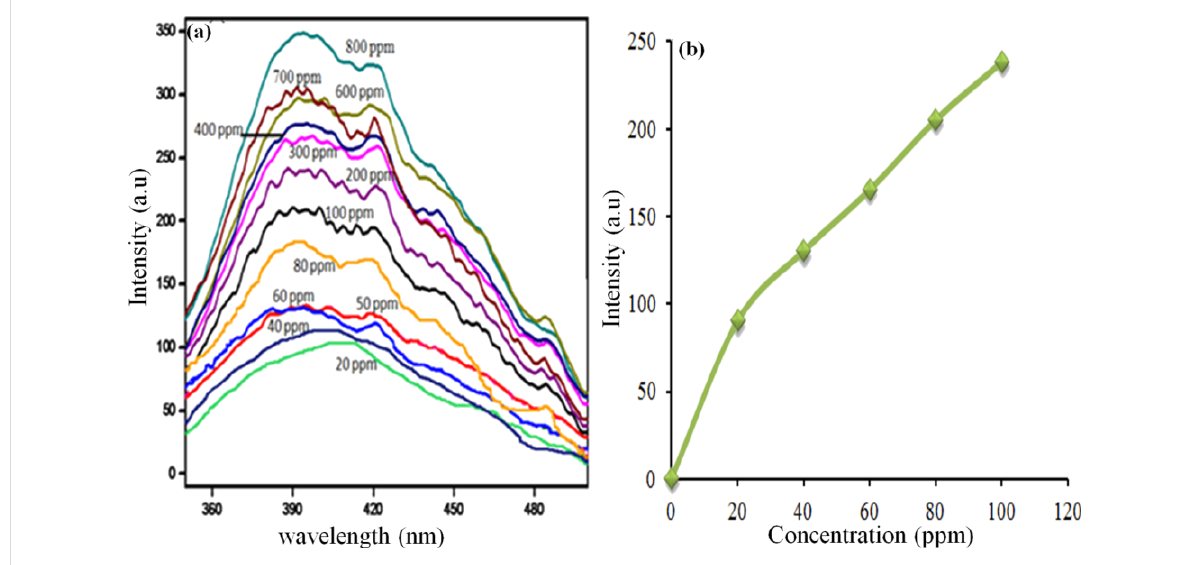
Figure 10: (a) Fluorescence intensity of Au–DNA nanocomposites with increasing concentration (ppm) of Mg 2+ and (b) the calibration curve of the fluorescence intensity vs concentration (ppm) of Mg 2+ ions.